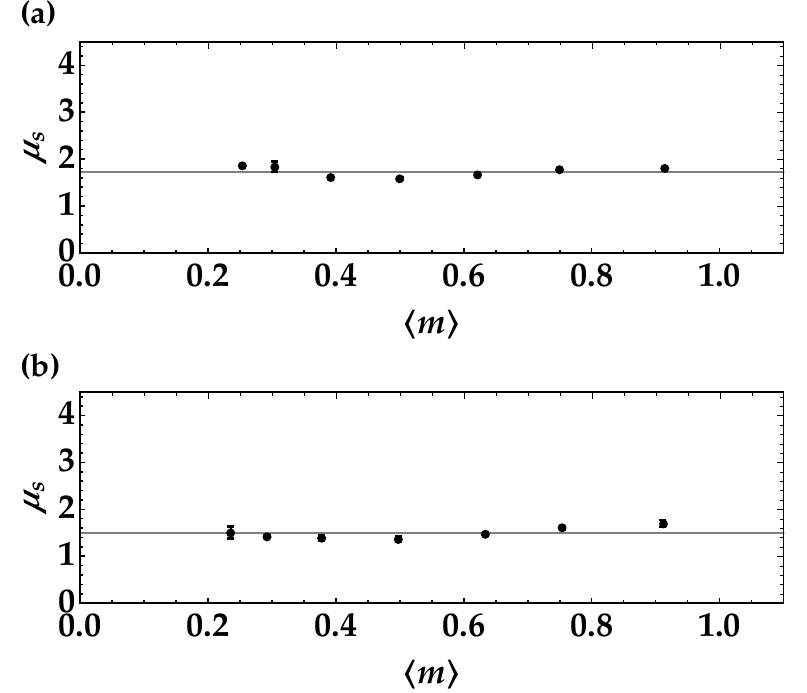
Figure 6. Values of µ s obtained by inverting Equation (7) applied to the experimental data as a function of the mean number of detected photons reconstructed at the two BS outputs. Black dots and error bars: experimental data; gray lines: values of µ s obtained from the fitting procedure applied to the data in Figure 5, namely, µ s = 1.72 in panel ( a ) and µ s = 1.48 in panel ( b